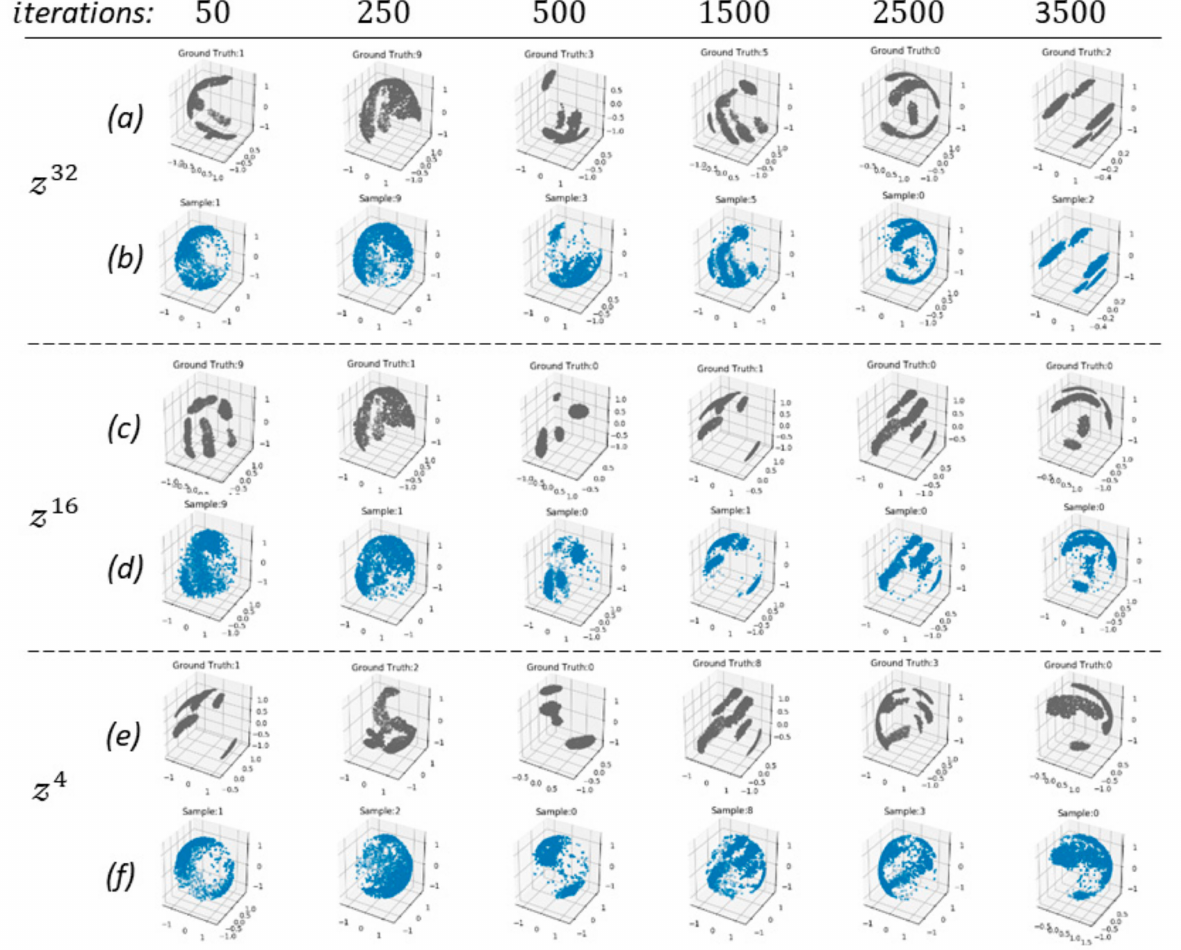
Figure 3. Reconstruction of object haptic information using the synergy-based encoder-decoder via CNF for three synergy dimensions. The illustrations are derived from training iterations: ( a ), ( c ), and ( e ) point clouds shown in gray are the ground truth haptic maps, the ( b ), ( d ), and ( f ) point clouds in blue are the reconstructed maps from CNF models with dimensions of z 32 , z 16 , z 4 ,